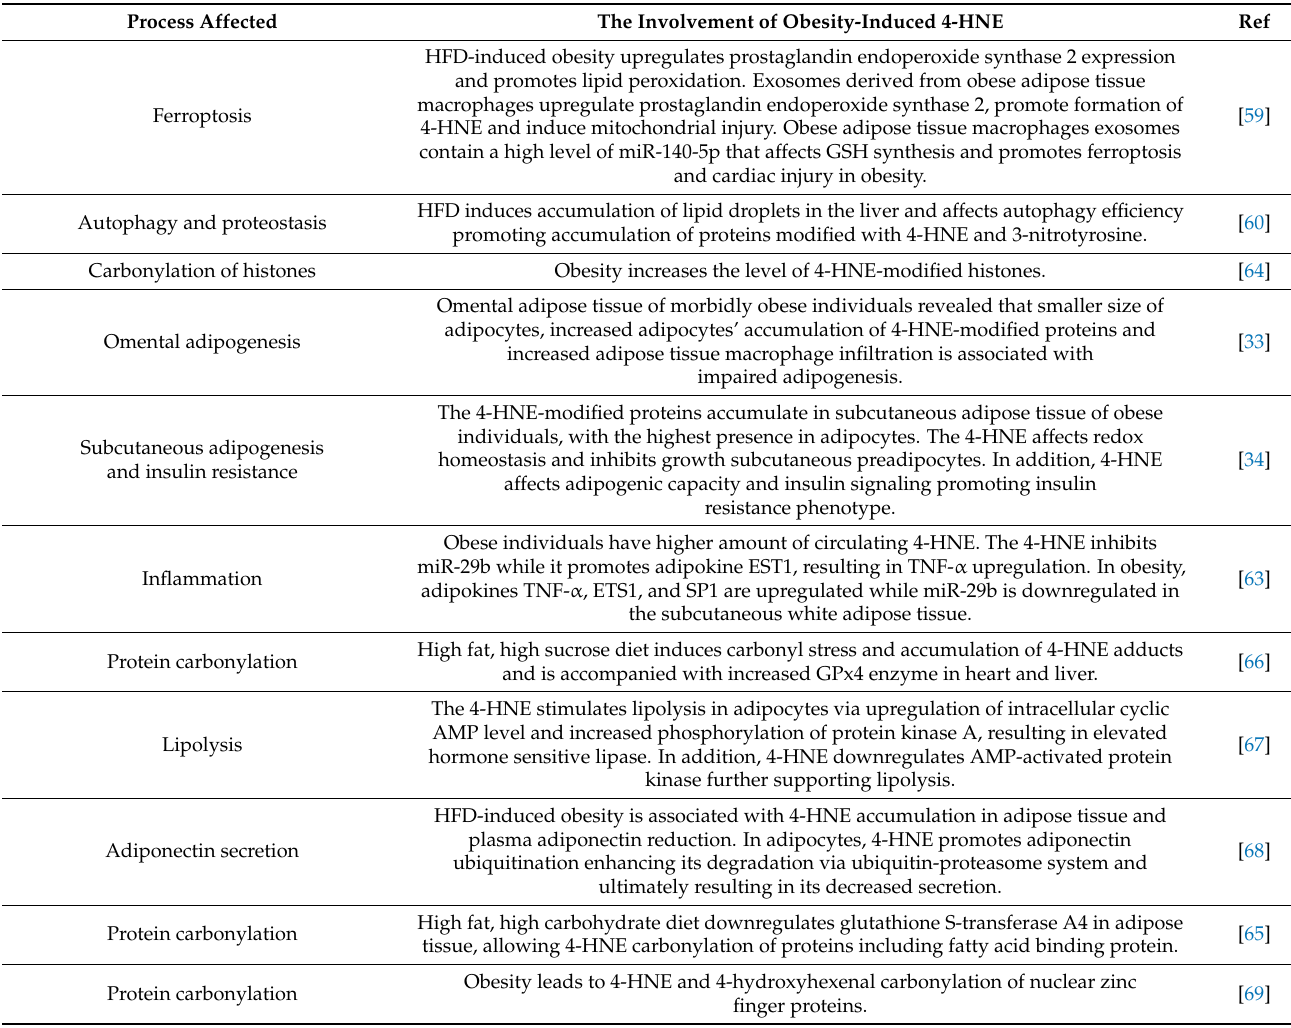
Table 1. Processes affected by obesity-induced